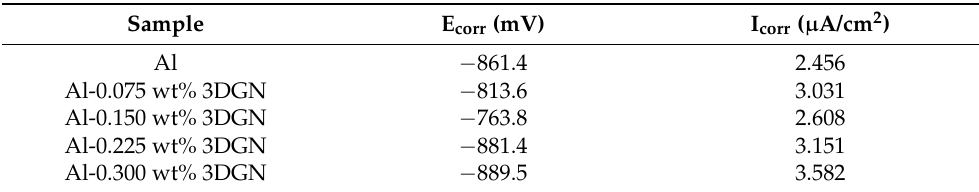
Figure 9. ( a ) Nyquist plots of 3DGN/Al composites and ( b ) potentiodynamic polarization curves of 3DGN/Al composites. Table 1. Corrosion potential (E corr ) and corrosion current density (I corr ) of the referenced pure aluminum sample and 3DGN/Al composites.